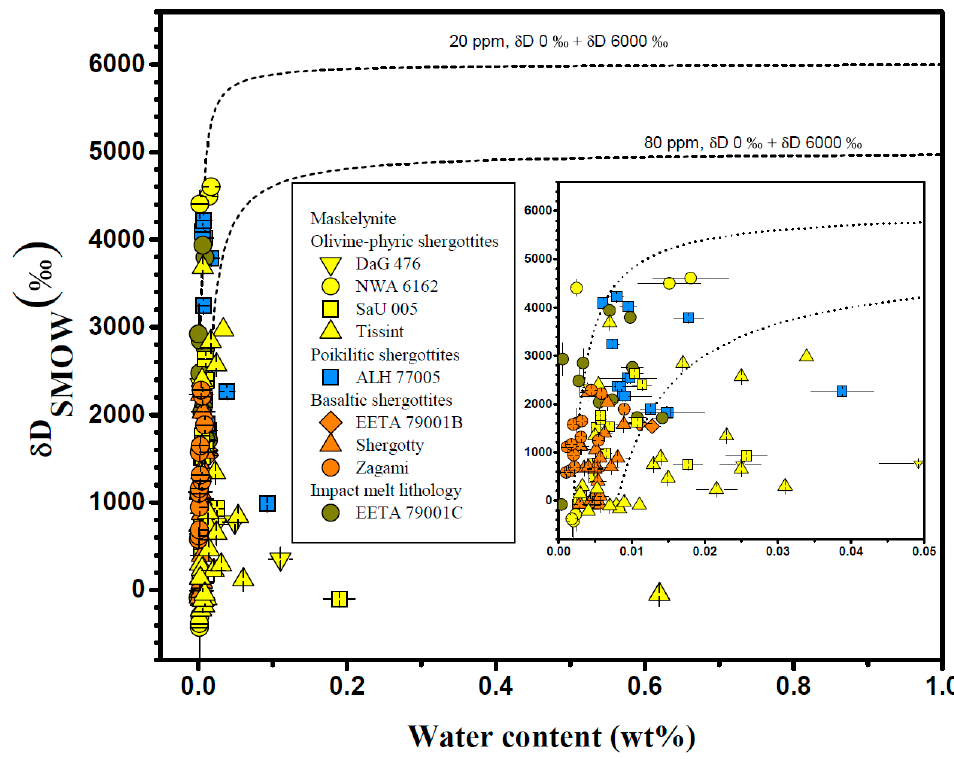
Figure 4. The relationship between water content and δ D values of shergottite maskelynite. Most shergottite maskelynite has water content less than 200 ppm but significantly large variation in δ D values, plotting along a two end-member mixing trend, except for several grains displaying a negative correlation between the water content and δ D values. The inset diagram magnifies the data ranging from 0 to 500 ppm. The dashed lines show the mixing of the post-erupted water (H 2 O = 20–80 ppm and δ D ~ 0 ‰) and the Martian crustal water ( δ D = 6060–5060 ‰) from [68] . Tissint from [52,60] , EETA 79001C from [71] , NWA 6162 from [35] , Shergotty and Zagami from [125] , ALH 77005 from [124] , and the other literatures are from [59] .